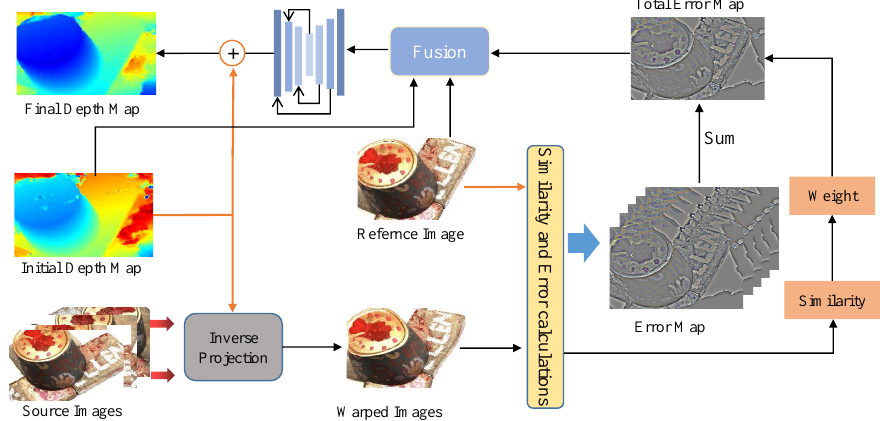
Figure 4. Error-Aware